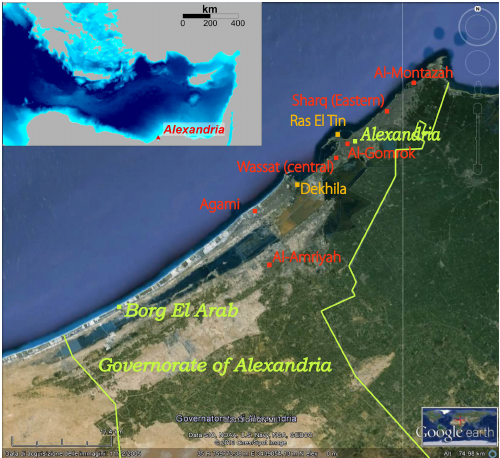
Figure 1. Governorate of Alexandria. Names of the districts are in red. Places that are affected by major inundations according to the computations of the paper are in orange. In the upper left corner there is a map of the eastern Mediterranean which includes Alexan-